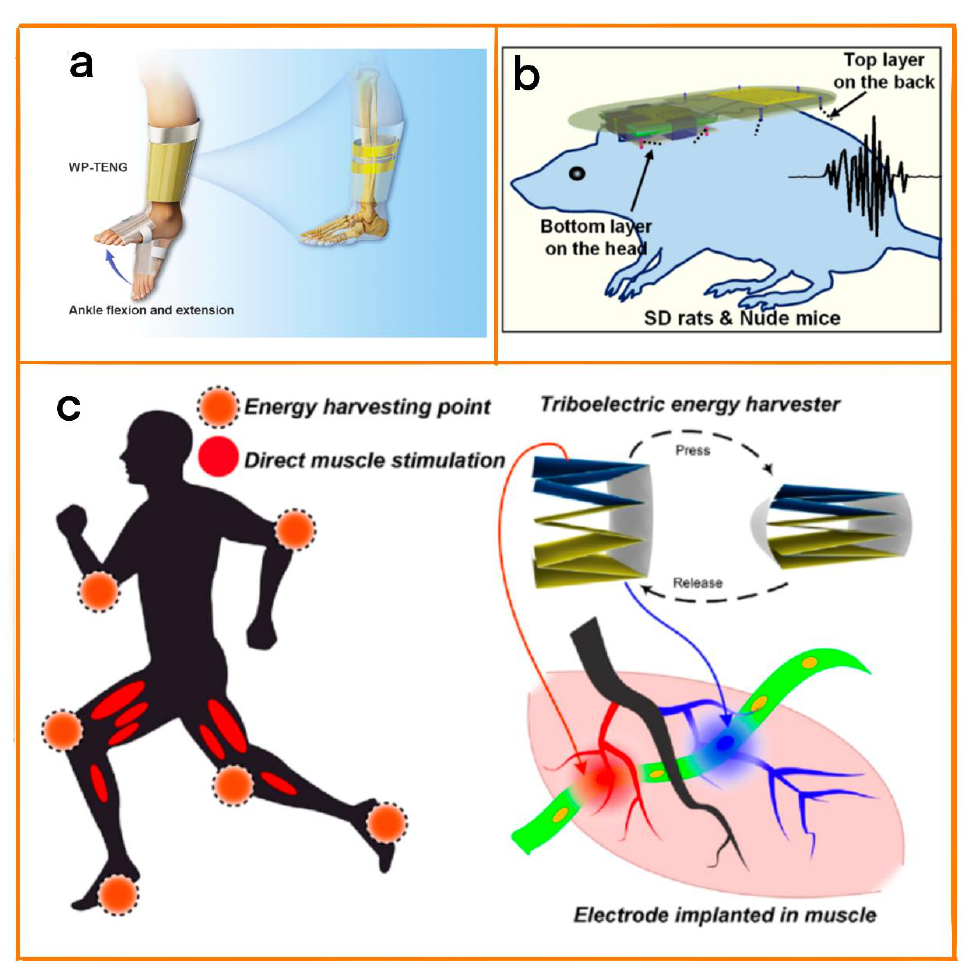
Figure 9. ( a ) Human limb movement activates the WP−TENG to achieve bone repair. Reprinted with permission from [71]. 2022, John Wiley and Sons. ( b ) Schematic diagram of M-ESD system for hair regeneration. Reprinted with permission from [74]. 2019, ACS. ( c ) Electrical muscle stimulation powered by TENGs. Reprinted with permission from [77]. 2019, ACS.